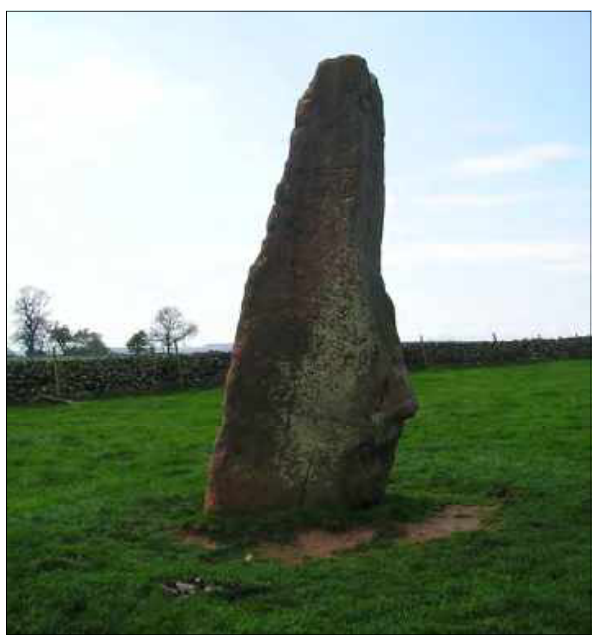
Fig 2.22 The standing stone Long Meg, Cumbria (Lucy